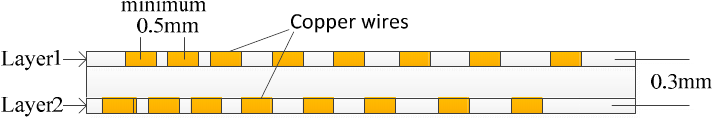
Figure 12. Schematic of the lateral view of the multi-layer coil Figure 12 ． Schematic of the lateral view of the multi-layer coil design. Figure 12 ． Schematic of the lateral view of the multi-layer coil design.